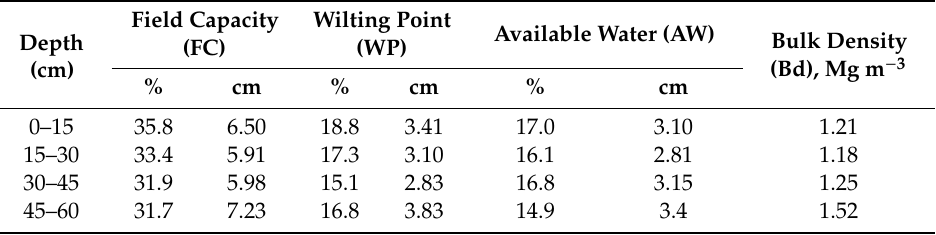
Table 1. Main soil moisture parameters and soil bulk density of the